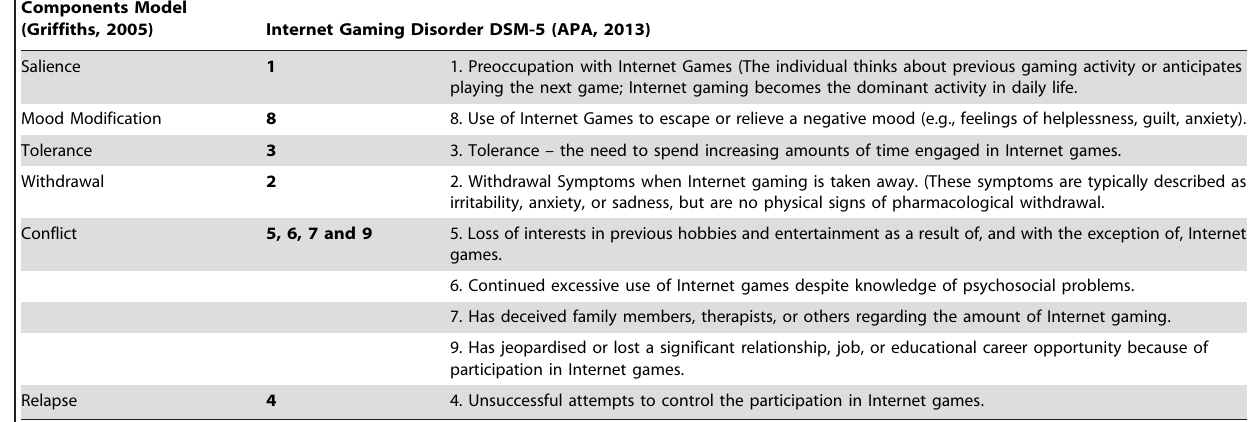
Components Model (Griffiths,